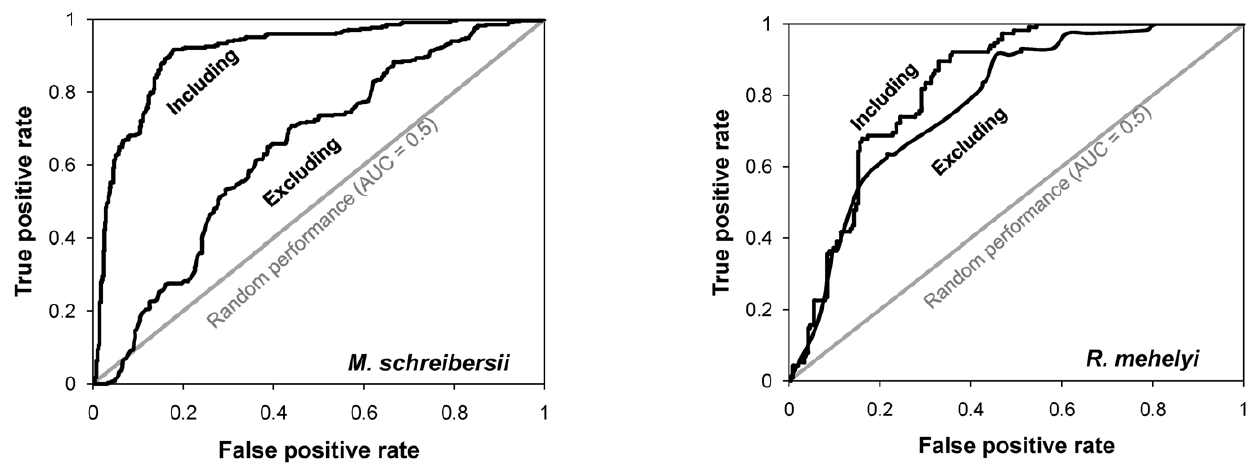
Figure 2. Comparison of the performance between selected models including and excluding distance variables. The comparison was performed using the area under the ROC curve (AUC). Note the low performance (smaller AUC) of the models that exclude the distance variables, particularly for M. schreibersii (see Table 2 for full model statistics).